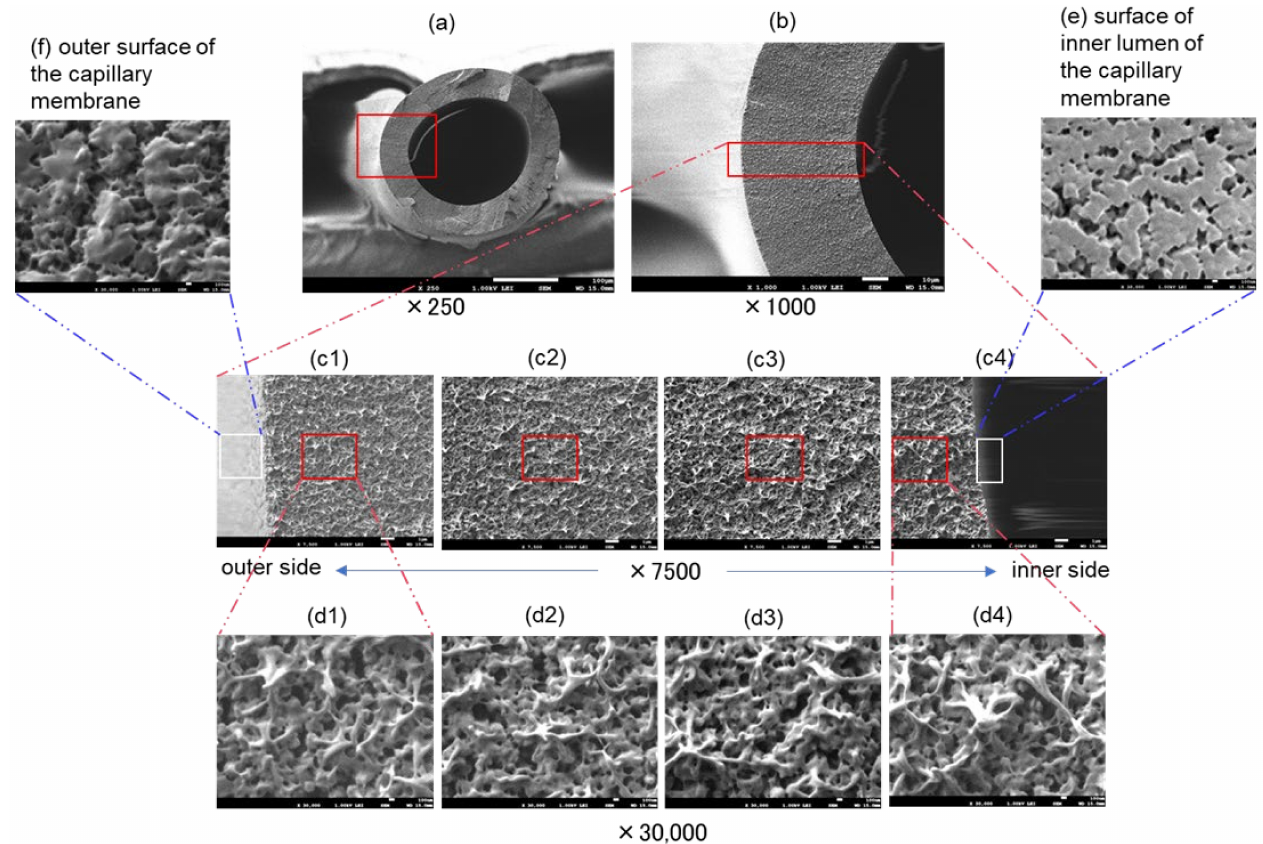
Figure 4. FE-SEM images of Capiox ® FX(dry), ( a – d ) cross sections and ( e ) inner and ( f ) outer surfaces of the capillary membrane. Magnifications are ( a ) × 250, ( b ) × 1000, ( c ) × 7500 and ( d – f ) × 30,000,